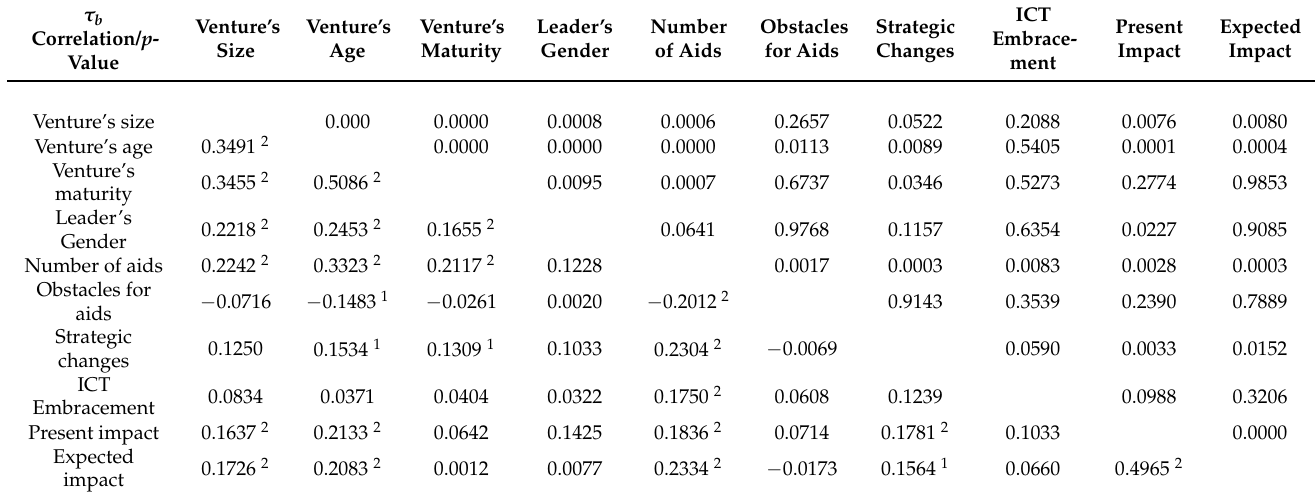
Table 2. Lower left: Kendall’s rank τ b correlation matrix of all ordinal and nominal-binary variables of the survey. Upper right: p -values of two-sided τ b Kendall’s test of rank correlation, where the null hypothesis value is zero correlation.